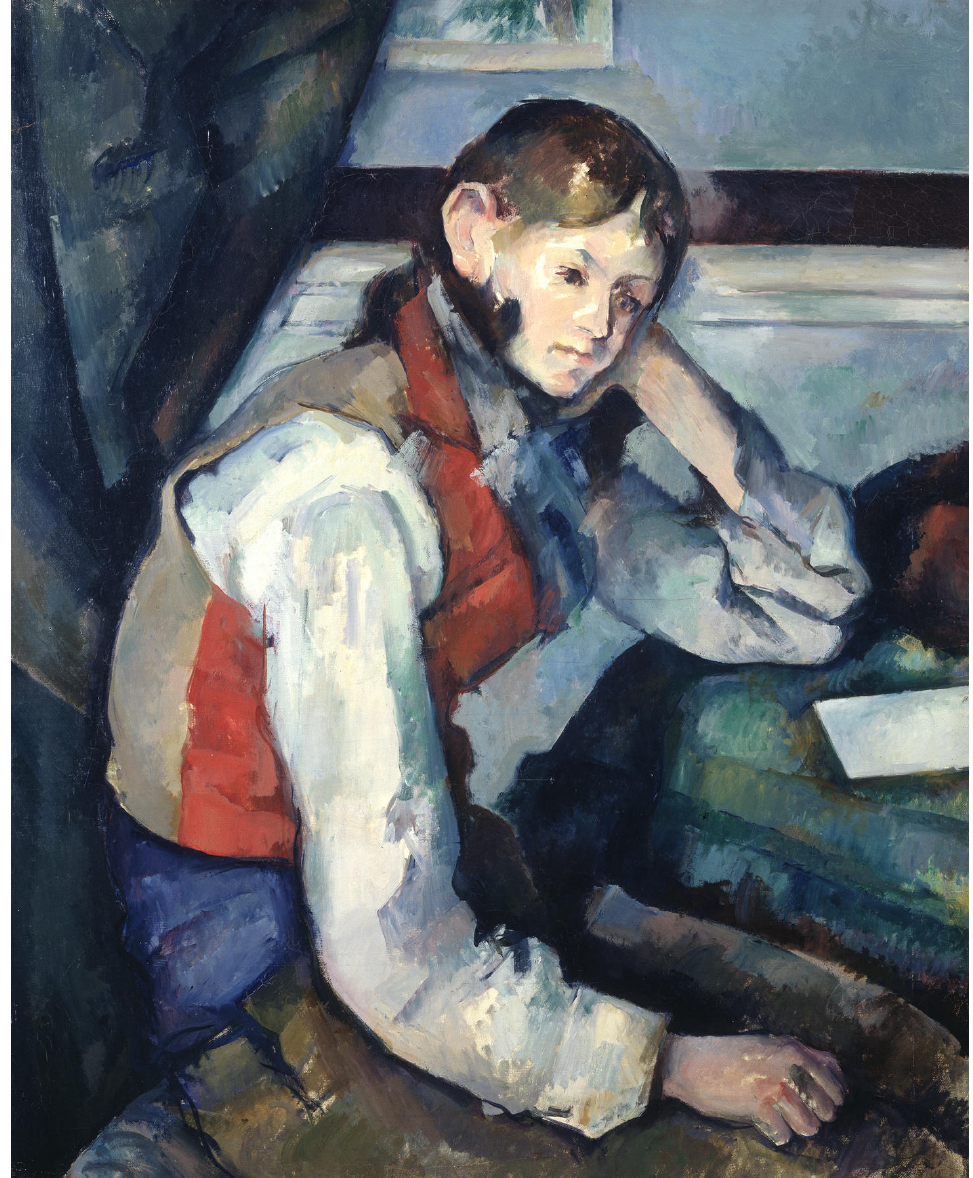
Figure 1: Paul Cézanne, The boy in the red waistcoat (Zürich, Sammlung